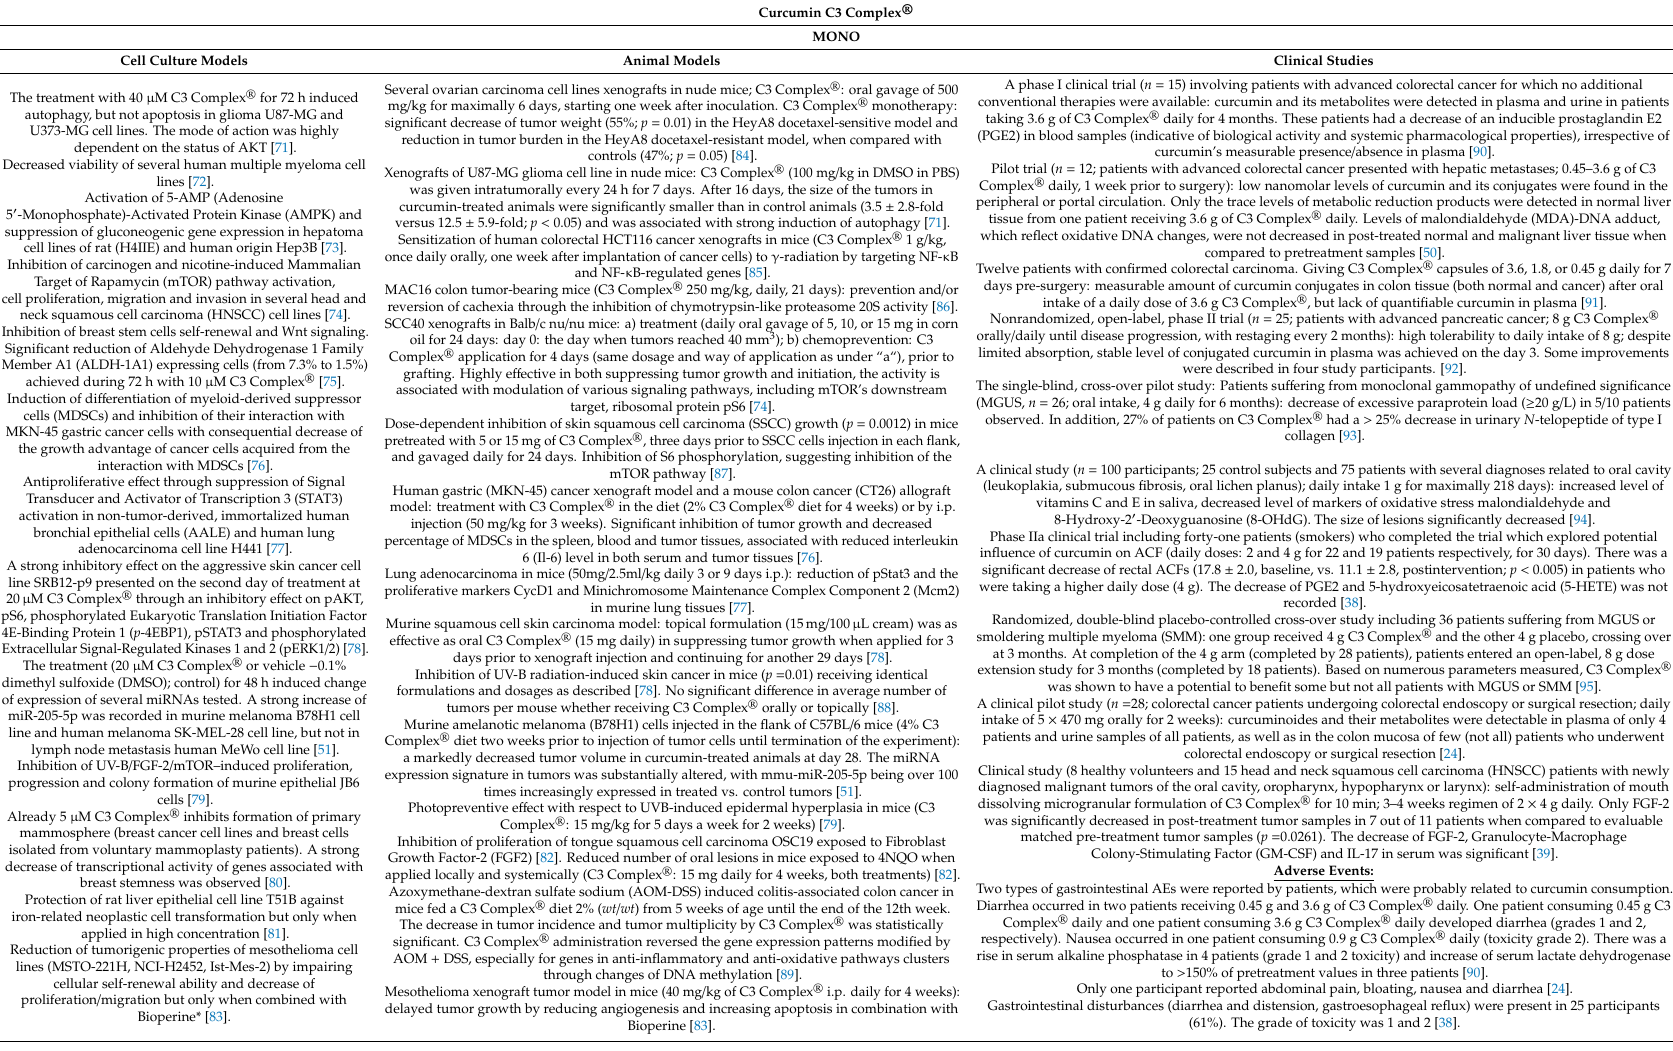
Table 2. E ff ects of C3 Complex ® obtained in vitro, in vivo and in clinical